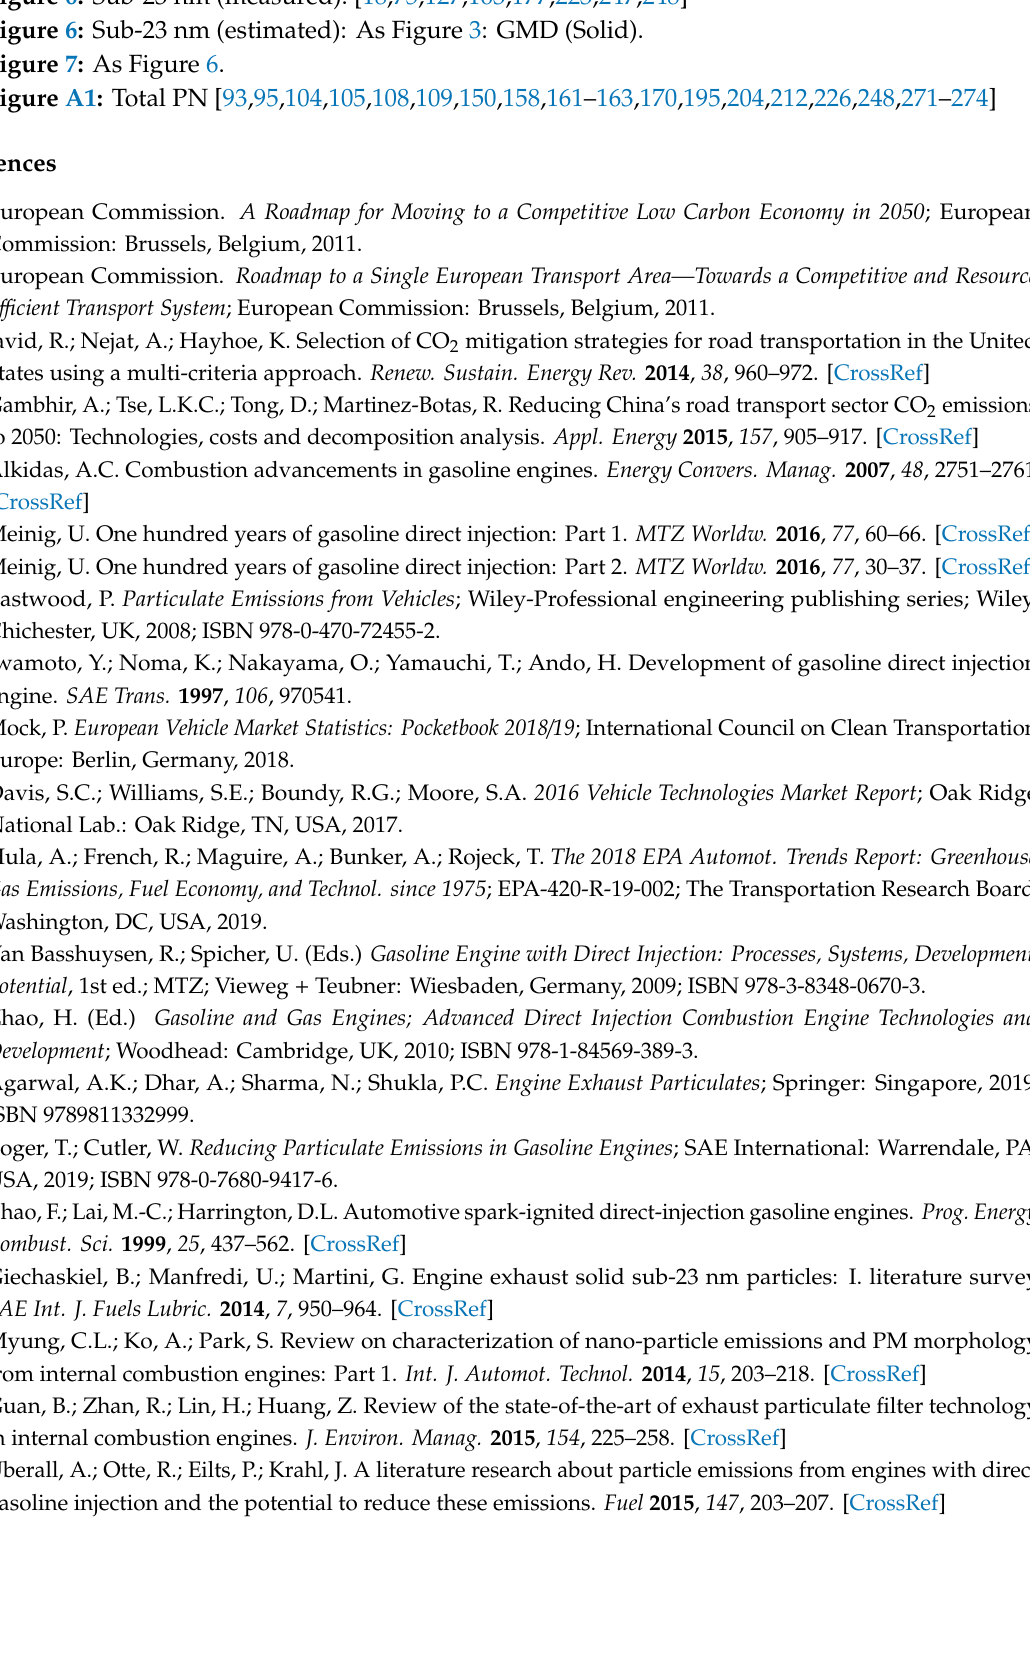
Figure 3: GMD (Total): [56,94,95,102,104,109,121,140,165–168,170,172,175,176,178,181,184,189,195, 198,204,210,212,213,231,236,237,254,263–271] Figure 4: Low temperature PM: [99,158,163,165,169,176,192,196,211,224,225] Figure 5: Low temperature SPN: [60,75,158,163,165,169,176,196,201,211,224–226,234,240,257] Figure 6: Sub-23 nm (measured): [18,75,127,163,177,223,247,248] Figure 6: Sub-23 nm (estimated): As Figure 3: GMD (Solid). Figure 7: As Figure 6. Figure A1: Total PN